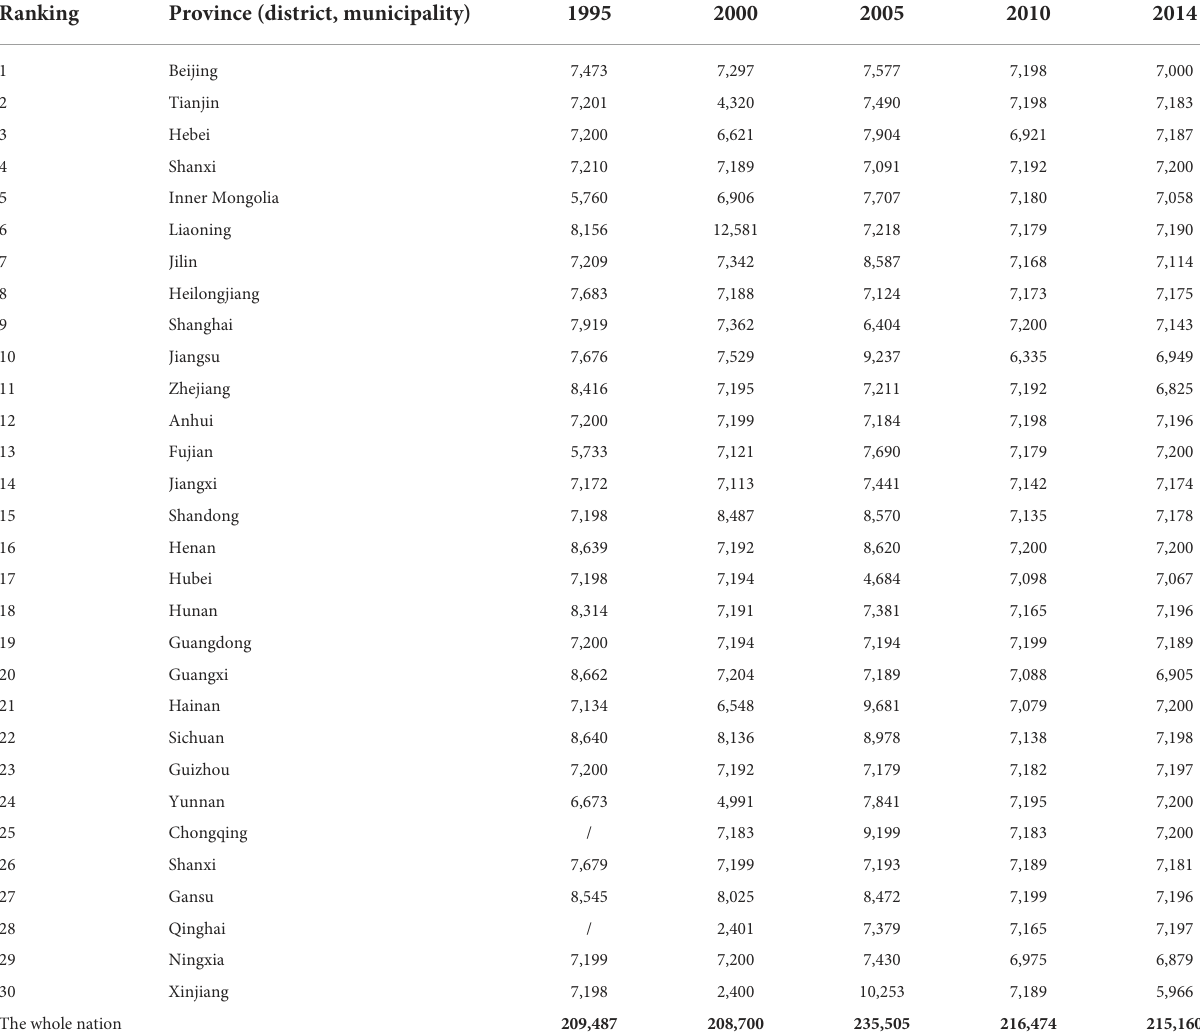
TABLE 1 The number of participants in each province in the survey from 1995 to 2014.